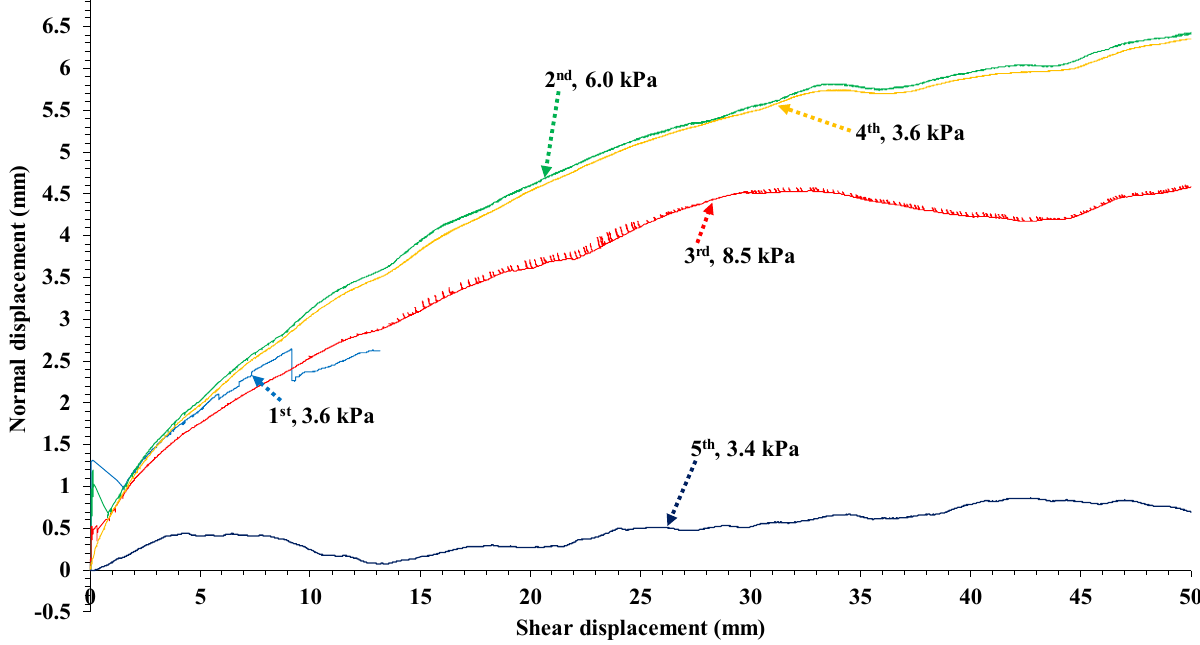
Figure 16. Average normal deformation during the shearing in each test stage of the large sample.